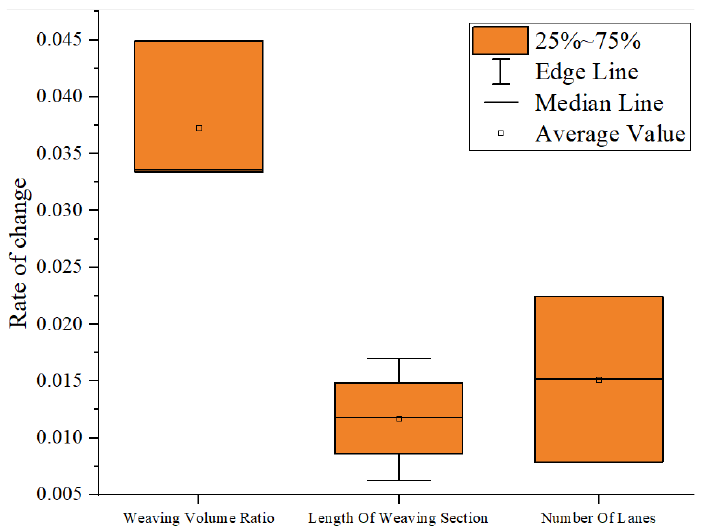
Figure 5. Sensitivity of speed catastrophe boundary based on all parameters.